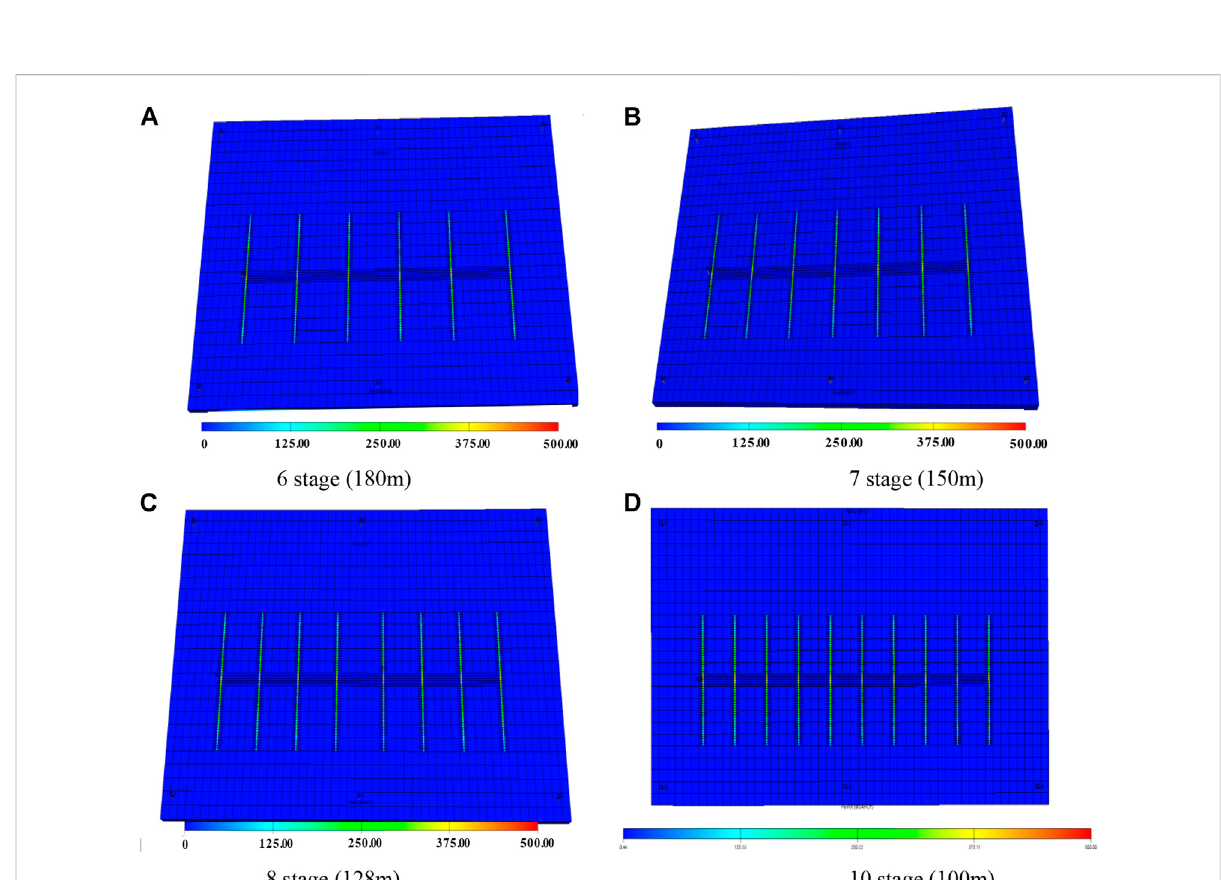
FIGURE 12 In fl uence of different interval distances on reservoir seepage fi